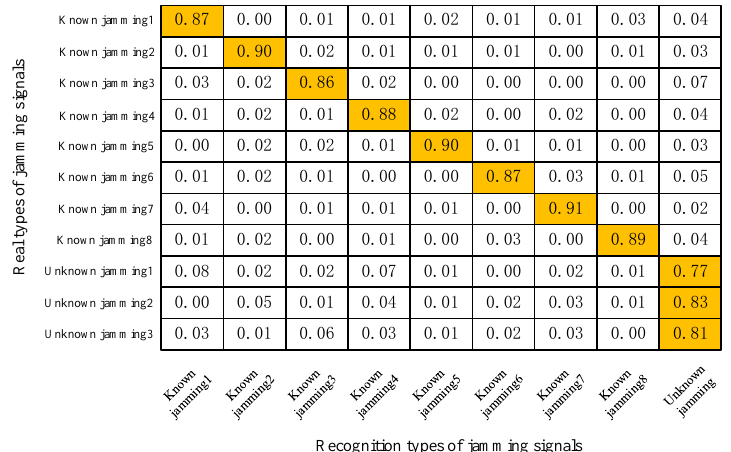
Figure 17. Recognition results of model based on OpenMax.